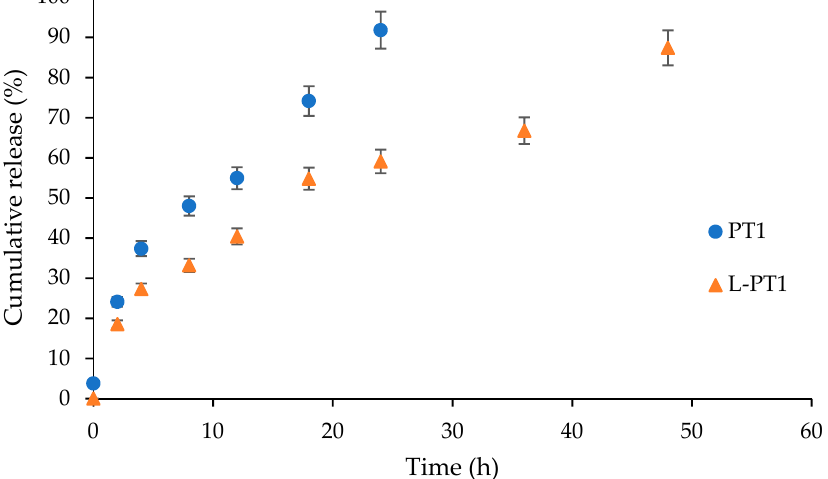
Figure 2. Release profile of plastein (PT1) and liposomes loaded with 1% plastein (L-PT1) prepared using thin film hydration during 48 h of dialysis at 28 ± 2 °C. Bars represent standard deviation ( n = 3).